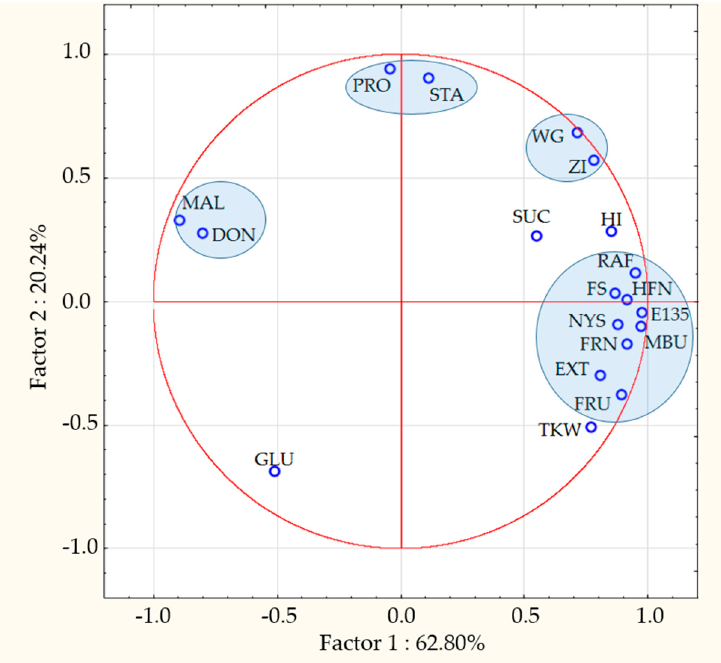
Figure 2. PCA graph of factor coordinates, grouping of the variables in two principal